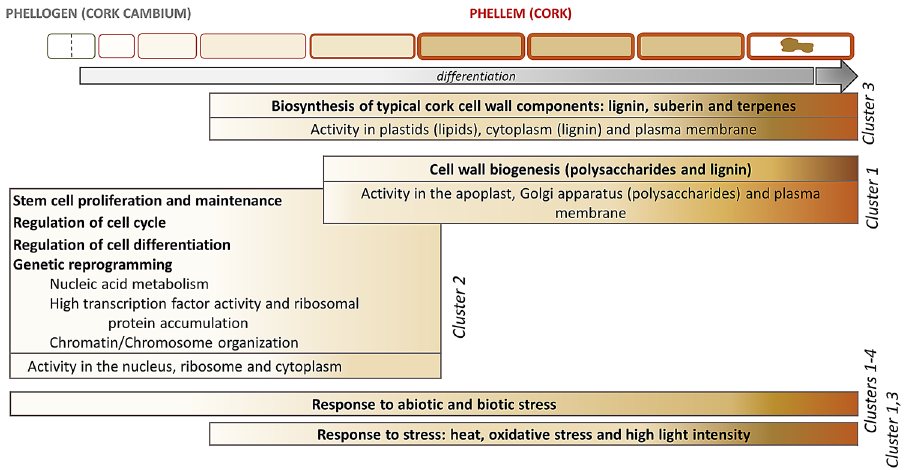
Figure 4. Summary of biological and molecular processes occurring during phellem cell ontogeny, from phellogen stem cell periclinal division to fully differentiated phellem cell, based on upregulated genes and processes in cork samples harvested in April, June and